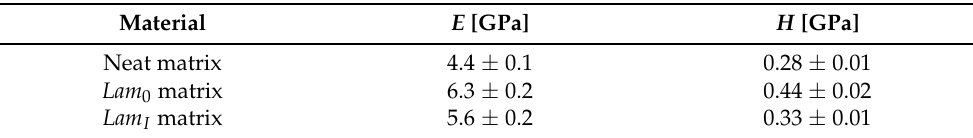
Table 3. Elastic modulus and hardness for neat matrix, untreated and treated laminates measured through